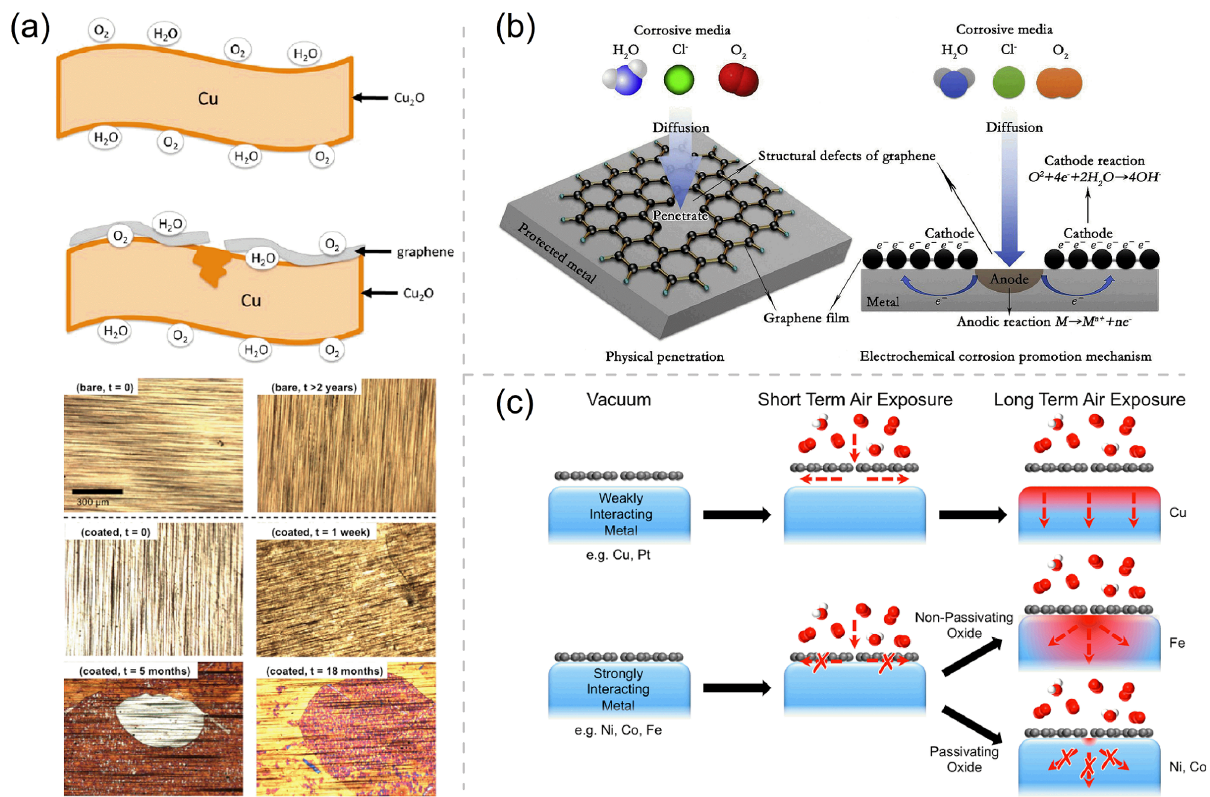
Figure 3. ( a ) The schematic of the oxide formation on bare and Gr-coated Cu, and the optical micrographs of bare and Gr-coated Cu foils before and after exposure to ambient conditions for 0 day, 1 week, 5 and 18 months, and 2 years. Adapted with permission from Reference [79]. Copyright 2013, American Chemical Society. ( b ) Schematic of galvanic corrosion occurring in the defects of pure graphene coating. Adapted with permission from Reference [10]. Copyright 2018, Elsevier. ( c ) Schematic showing the passivation function of different Gr-coated metals. Adapted with permission from Reference [62]. Copyright 2015, American Chemical